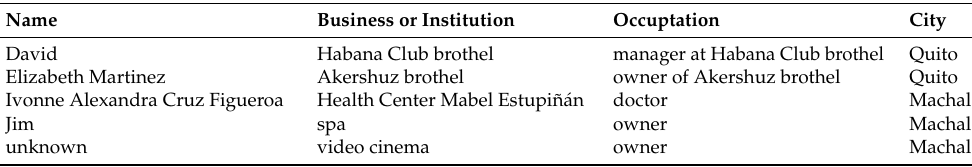
Table A8. Interviews with other actors in